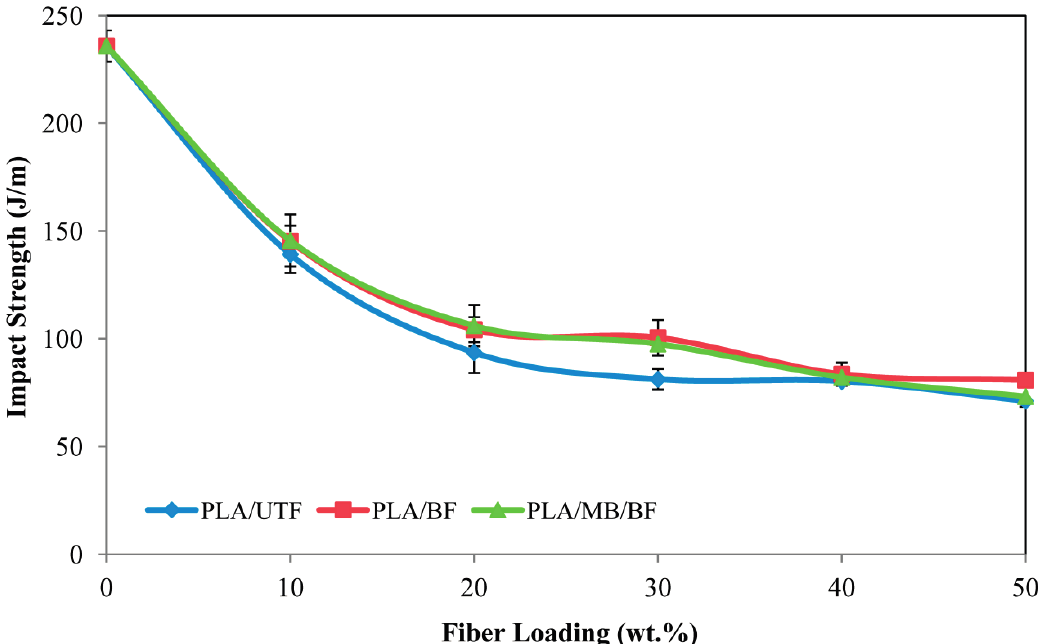
Figure 9. Impact strength of PLA/UTF, PLA/BF and PLA/MB/BF